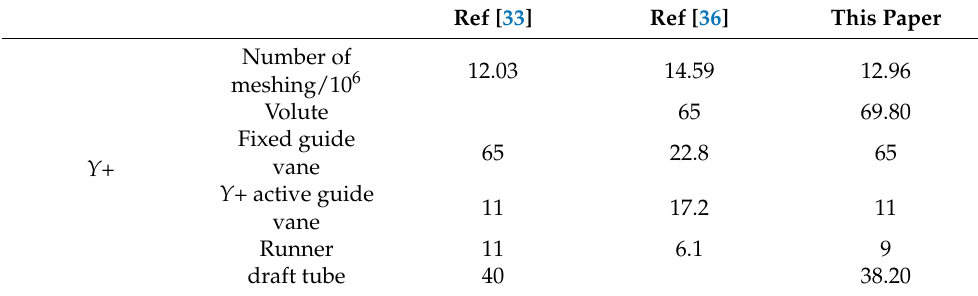
Table 1. Meshing and Y+ values.